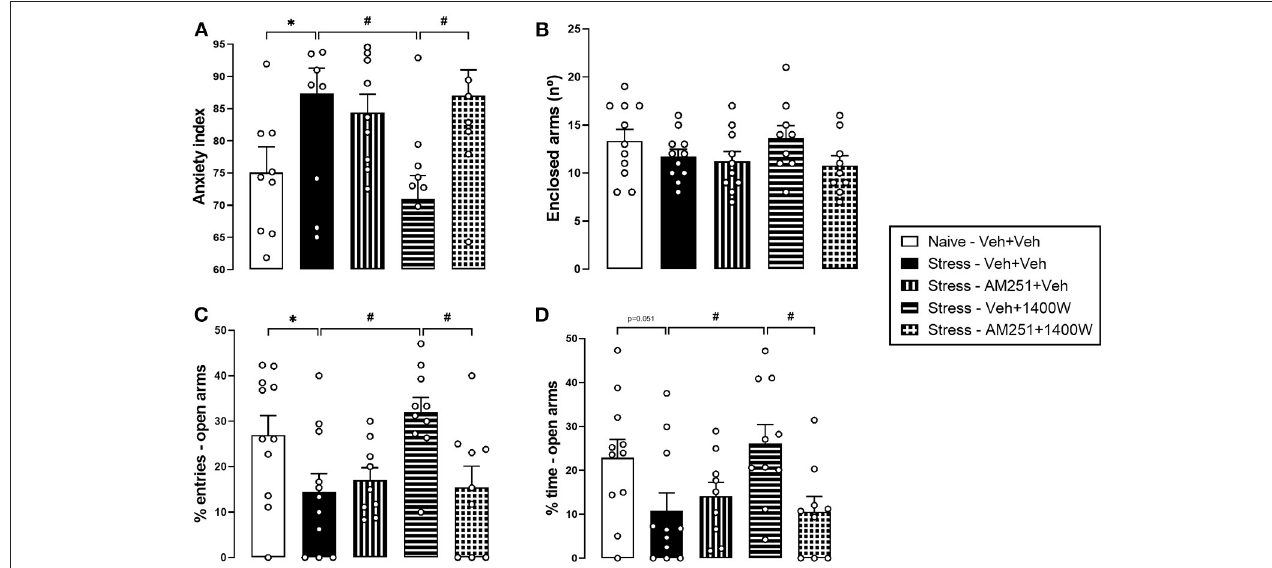
FIGURE 4 | Cannabinoid type 1 (CB 1 ) receptor antagonist prevented 1400W effects on restraint stress-induced behavioral consequences in the elevated plus-maze (EPM) 24h later. Pretreatment with the CB 1 receptor antagonist AM251 (100 pmol) suppressed the 1400W effect in the anxiety index (A) and percentage of entries (C) and time (D) in the open arms of the maze. There was no change in the enclosed arm entries (B) . Bars represent the mean ± standard error of the mean (SEM). *Indicates p < 0.05 in the Student t -test; # Indicates p < 0.05 in Tukey post-hoc test. n = 11, 11, 9, 10, and 9 for Naïve-Veh + Veh, Stress-Veh + Veh, Stress-Am251 + Veh, Stress-Veh + 1400W and Stress-AM251 + 1400W,